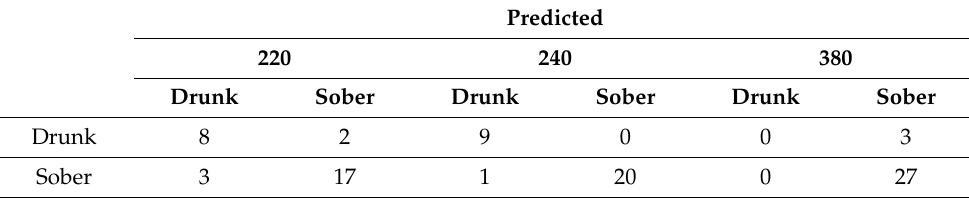
Table 4. Confusion matrices of the AdaBoost classifier for BrAC thresholds of 220, 240, and